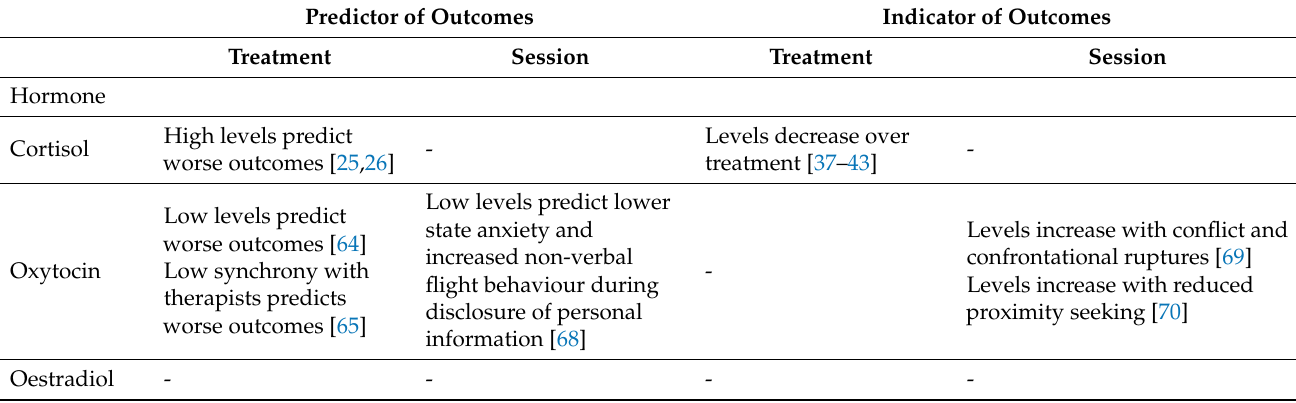
Table 1. Summary of studies investigating the relationship between hormones and psychotherapy in individuals with